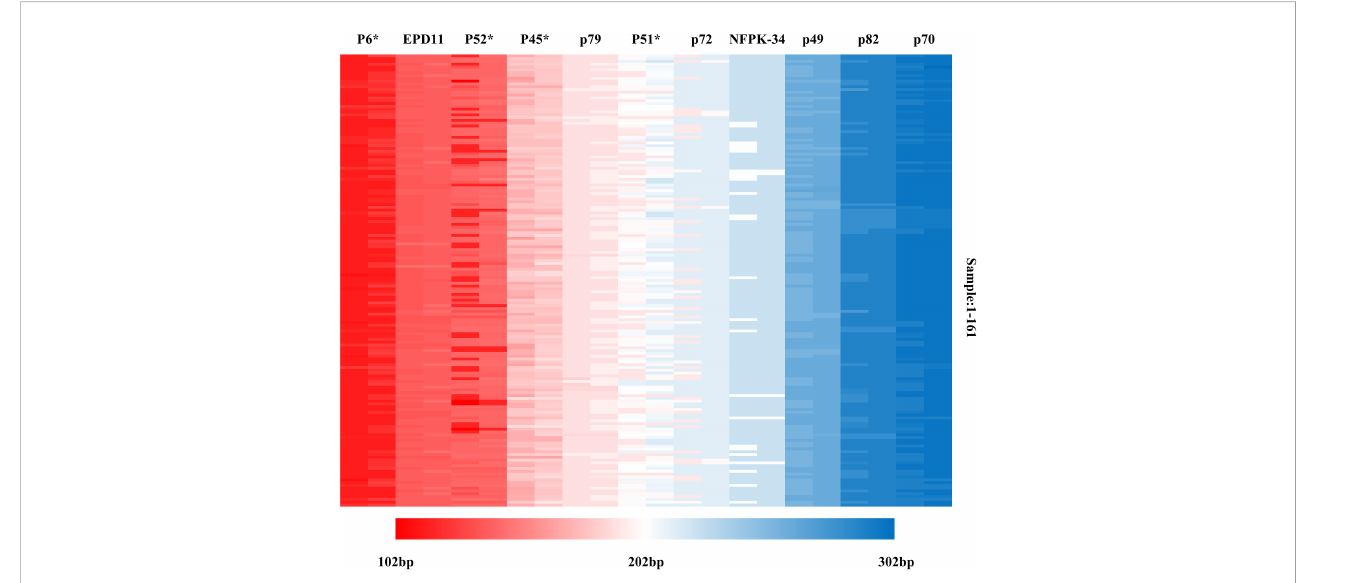
FIGURE 7 Molecular fi ngerprinting of Korean pine clones. (The different color blocks represent the corresponding allele fragment